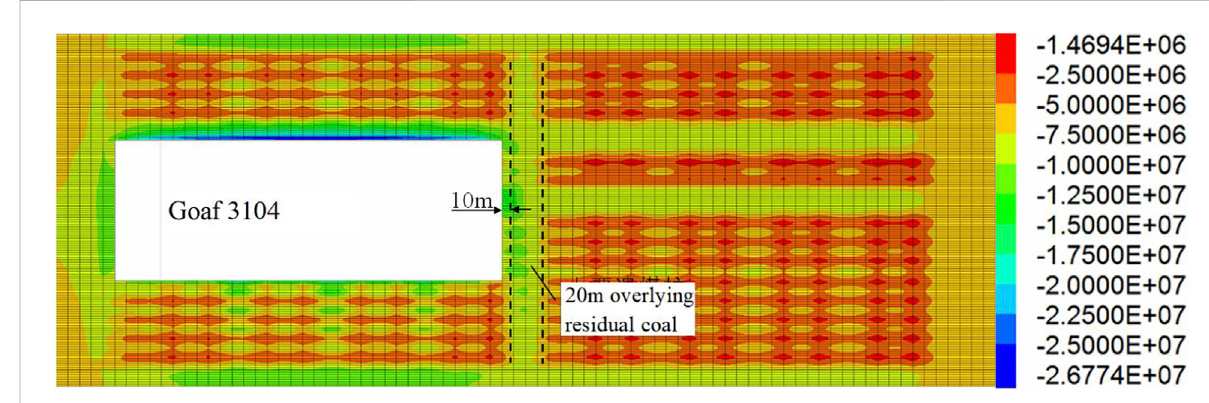
FIGURE 24 Cloud diagram of vertical stress distribution at 10m of overlying residual coal pillar